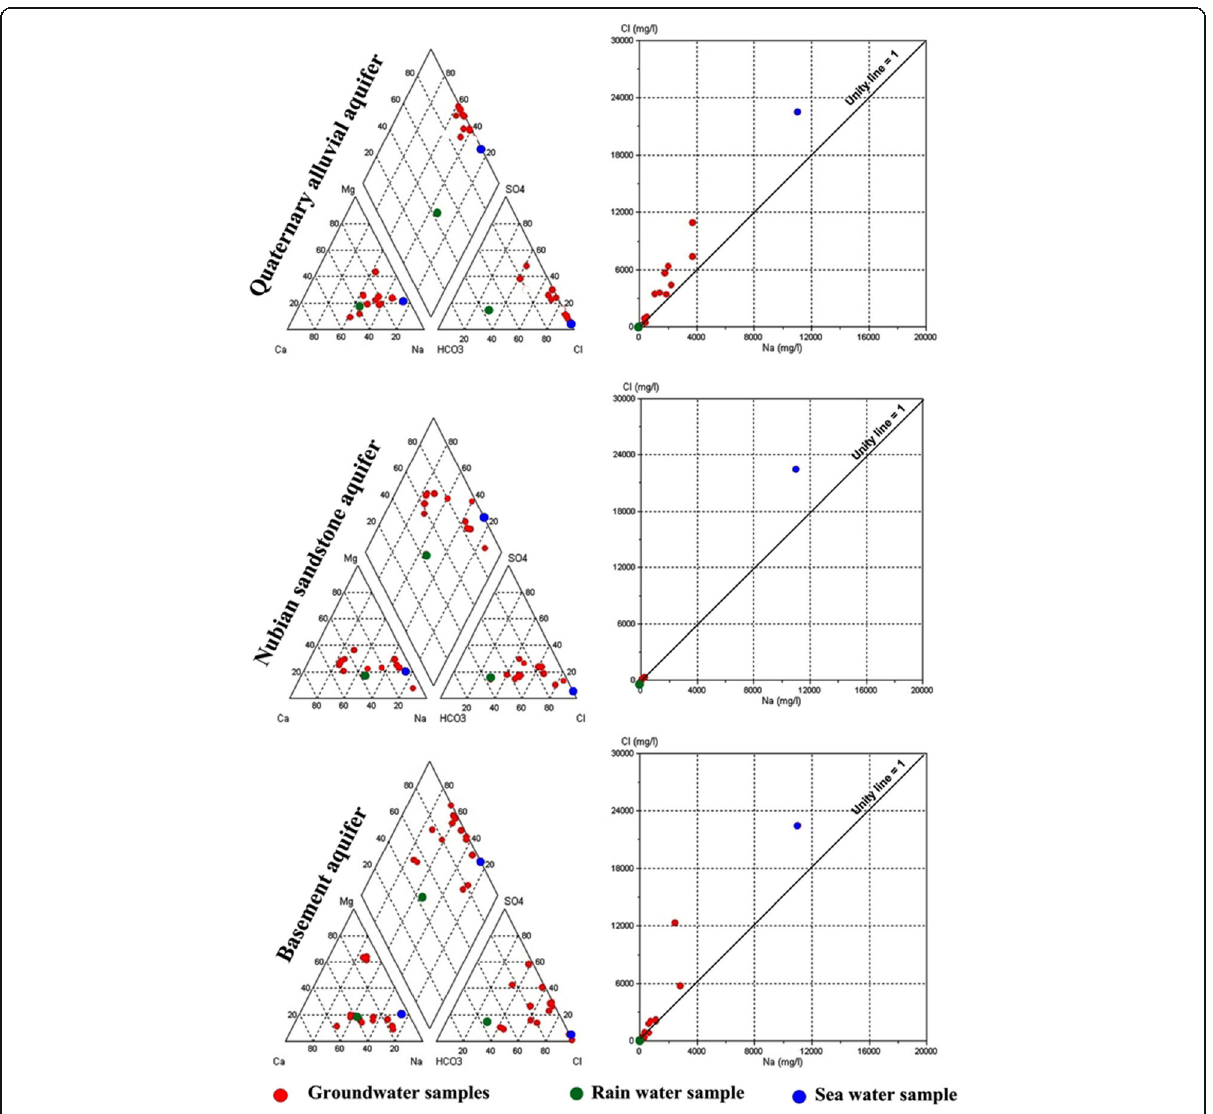
Fig. 13 Groundwater wells from the studied aquifers plotted on Piper diagram and scattered plot of